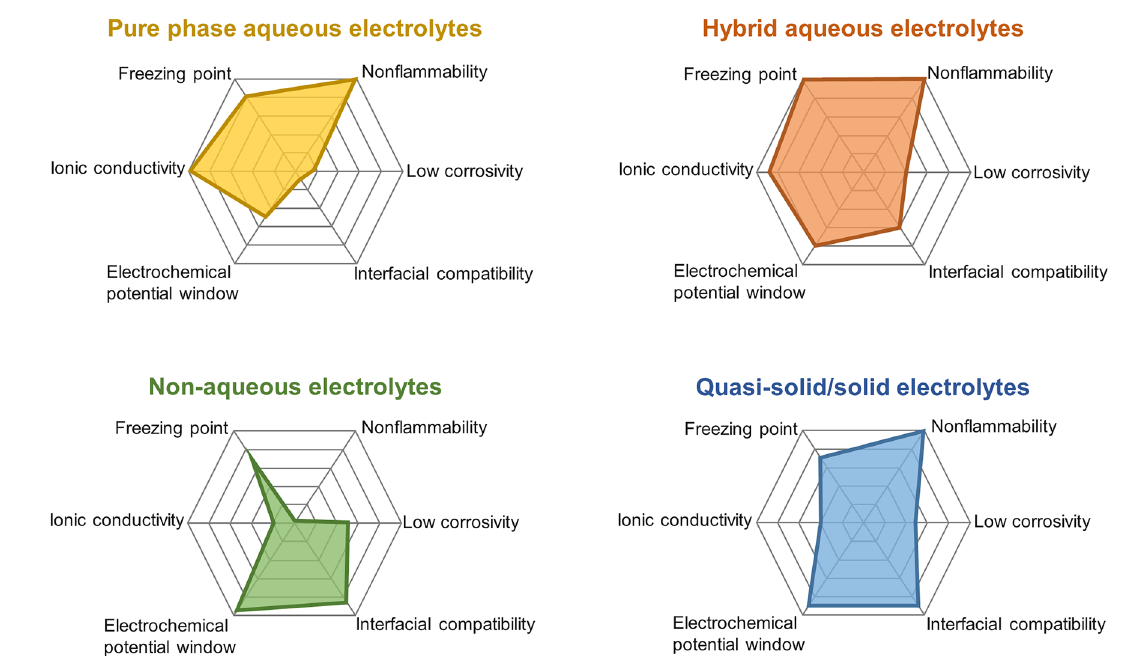
Fig. 8 Comparison of electrolytes for proton batteries in aspects of their different physical and electrochemical